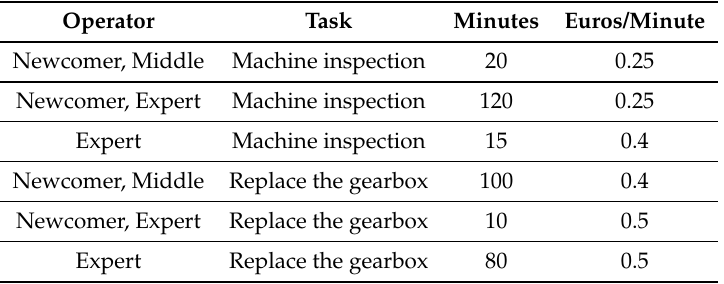
Table 5. Information used by the scheduling service for the experiment.